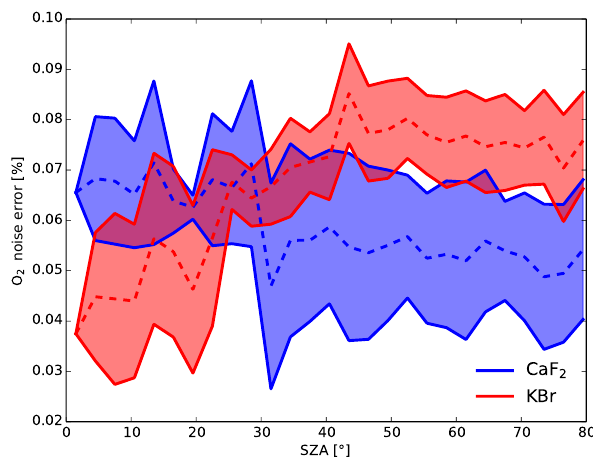
Figure 4. Mean noise error from PROFFIT for O 2 total column as a function of